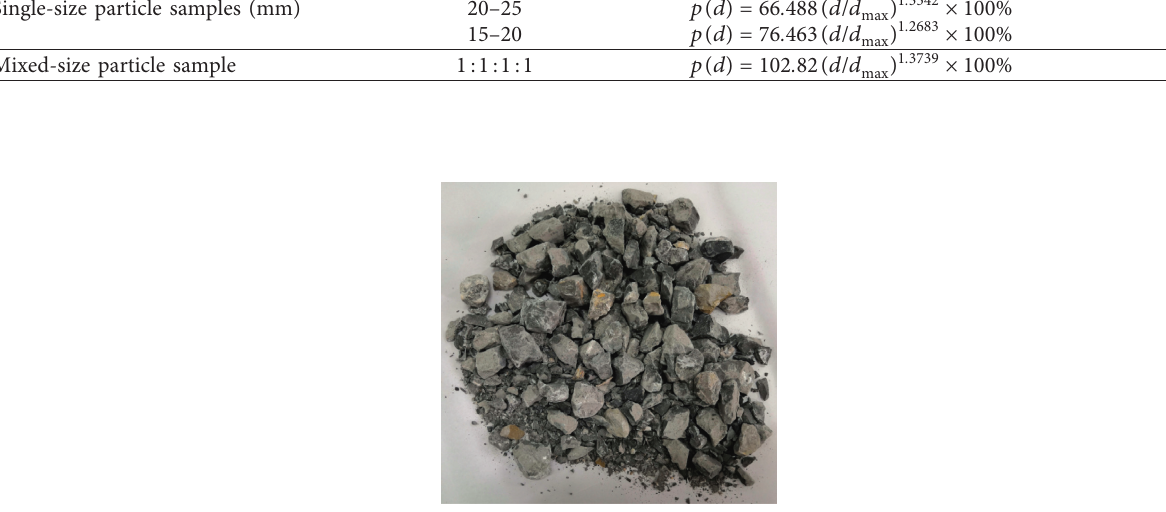
Figure 7: The crushed rock particles after